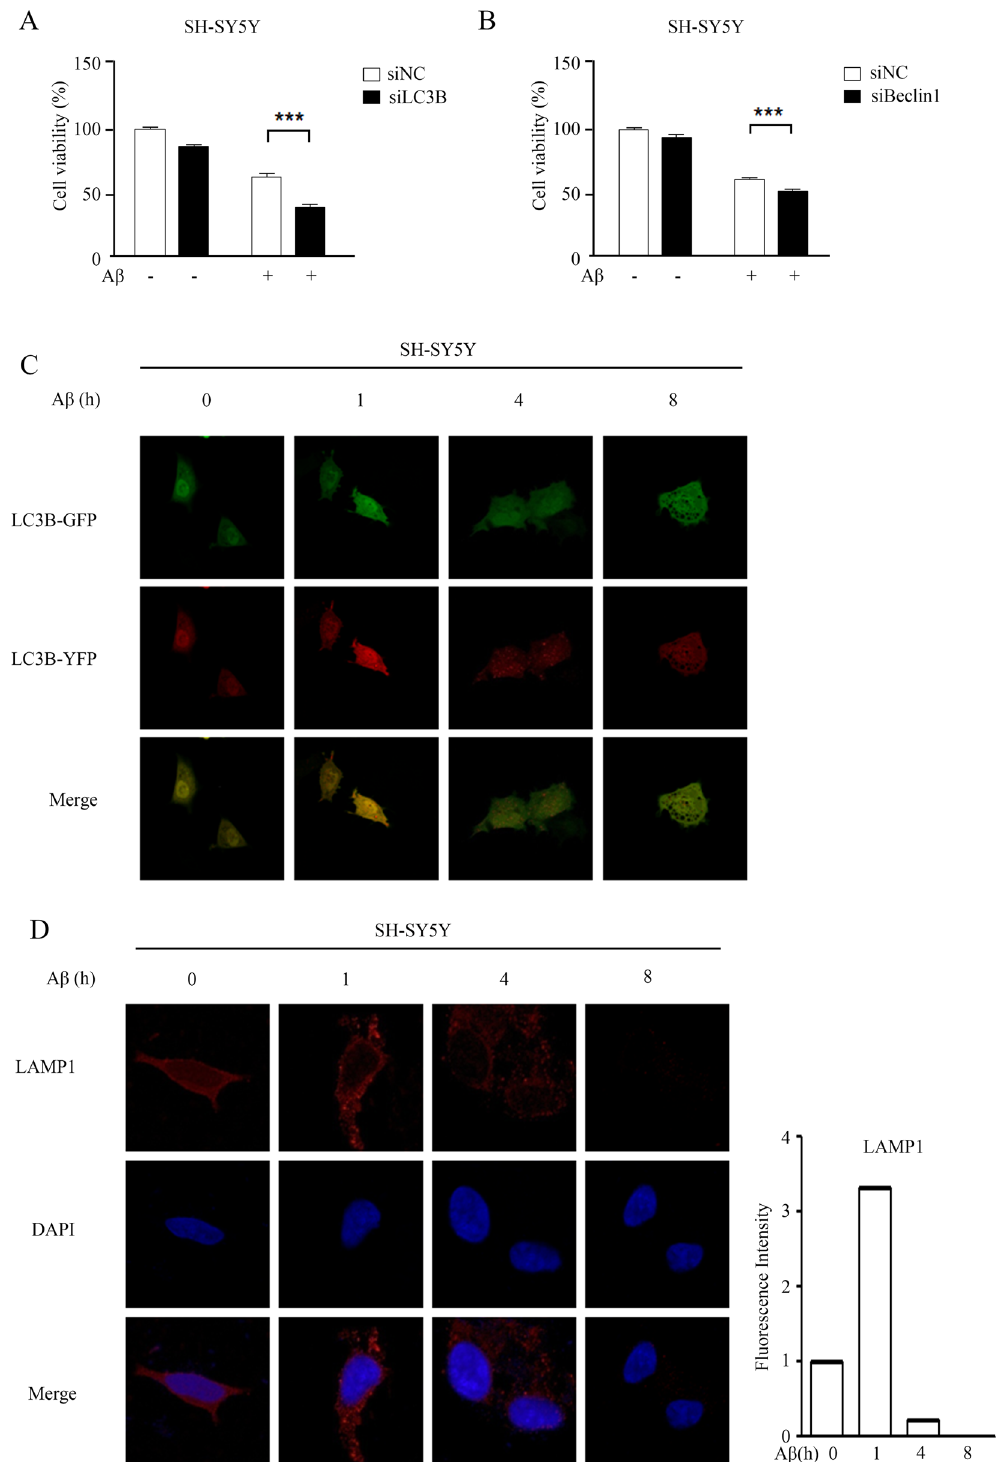
Figure 2. Autophagy in A β 25-35 -induced cell death is protective. ( A ) After knockdown of LC3B , the cells were treated with A β 25-35 for 16 h, and cell viability was detected by MTT. *** P < 0.001 compared with negative- control siRNA- and A β 25-35 -treated cells. ( B ) After BECN-1 knockdown, cells were treated with A β 25-35 for 16 h, and the cell viability was detected by MTT. *** P < 0.001 compared with negative-control siRNA- and A β 25-35 - treated cells. ( C ) SH-SY5Y cells were treated with A β 25-35 for 0–16 h. The green color indicates LC3B on the autophagosome. The red color indicates LC3B on the autophago-lysosome, and the yellow color is the merge of the two. ( D ) Cells were treated with 20 μ M A β 25-35 for 0–16 h. The red color indicates immunofluorescence staining of LAMP1, a marker of the lysosome, demonstrating the number of lysosomes in cells. The blue color indicates the cell nucleus. The right panel contains the merged